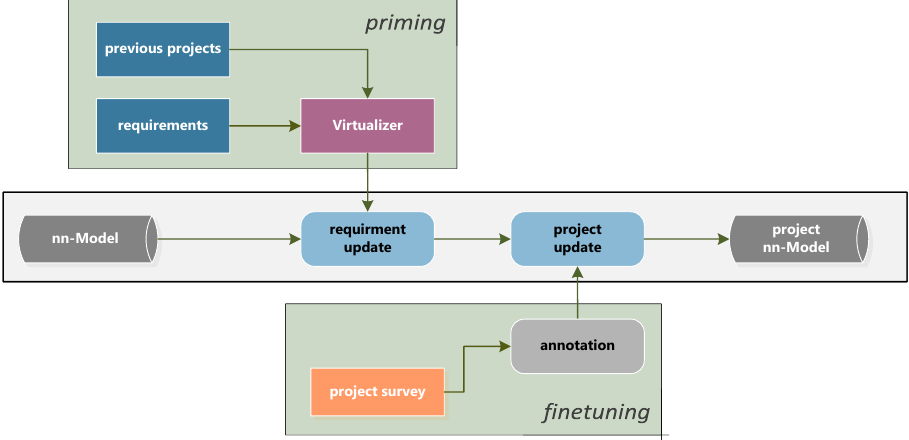
Figure 1. Overview of priming methodology. In case of a new survey, the Virtualizer will convert the CAD models into synthetic point clouds based on the new project requirements. These point clouds are used to update and preconfigure the nn-Model, reducing the data and training requirements on the second survey-driven updating step. The result is a project-specific neural